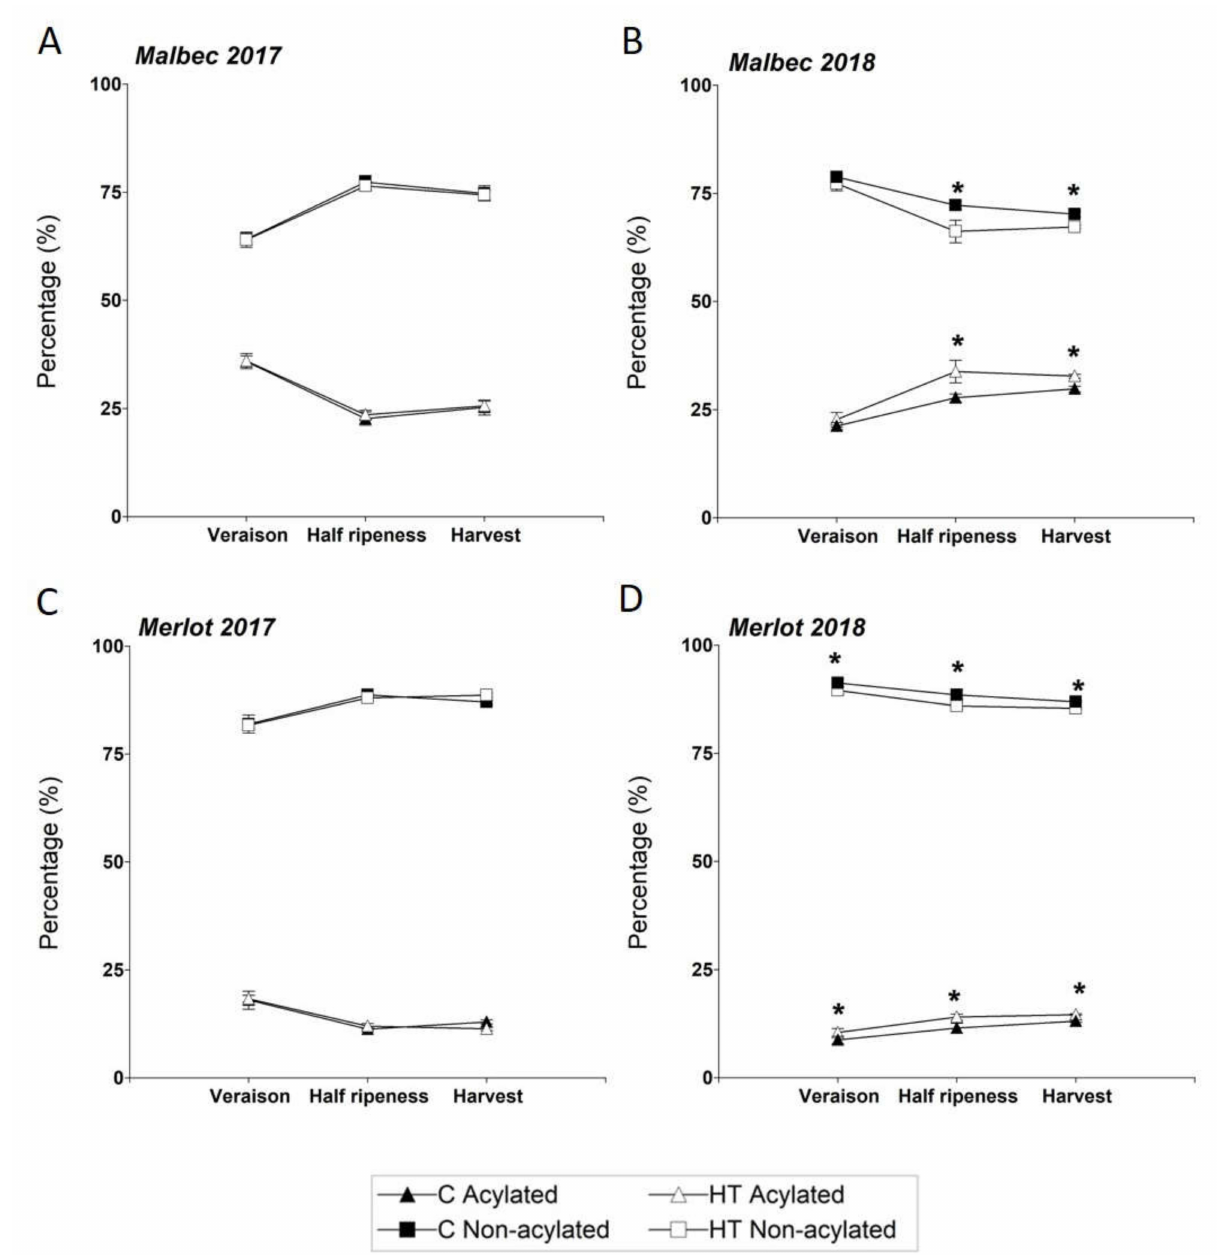
Figure 3. Relative content (%) of acylated and non-acylated anthocyanins in berries of Malbec ( A , B ) and Merlot ( C , D ) grown under high (HT) and control temperature ( C ) conditions in 2017 and 2018. Error bars represent standard errors from four replicates. * indicate statistical difference ( p < 0.05) between treatments at a given phenological stage (LSD